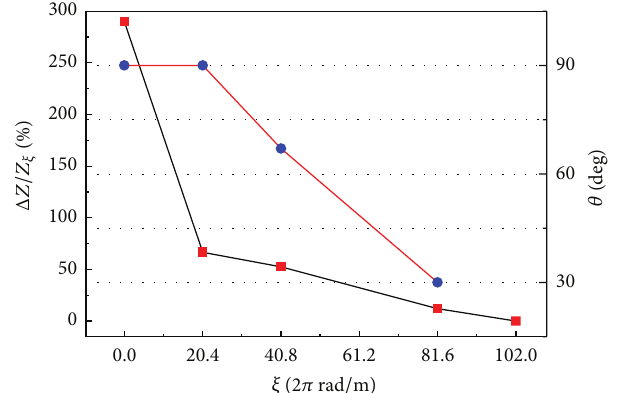
Figure 4: Torsional strain 𝜉 dependence of the maximum MI ratios and domain wall angle 𝜃